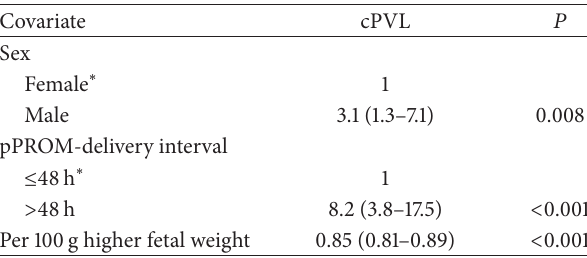
Table 3: Multivariate logistic regression analysis of the influence of fetal sex, preterm premature rupture of the membranes- (pPROM-) delivery interval, and birth weight on cystic periventricular leuko- malacia (cPVL) prevalence.